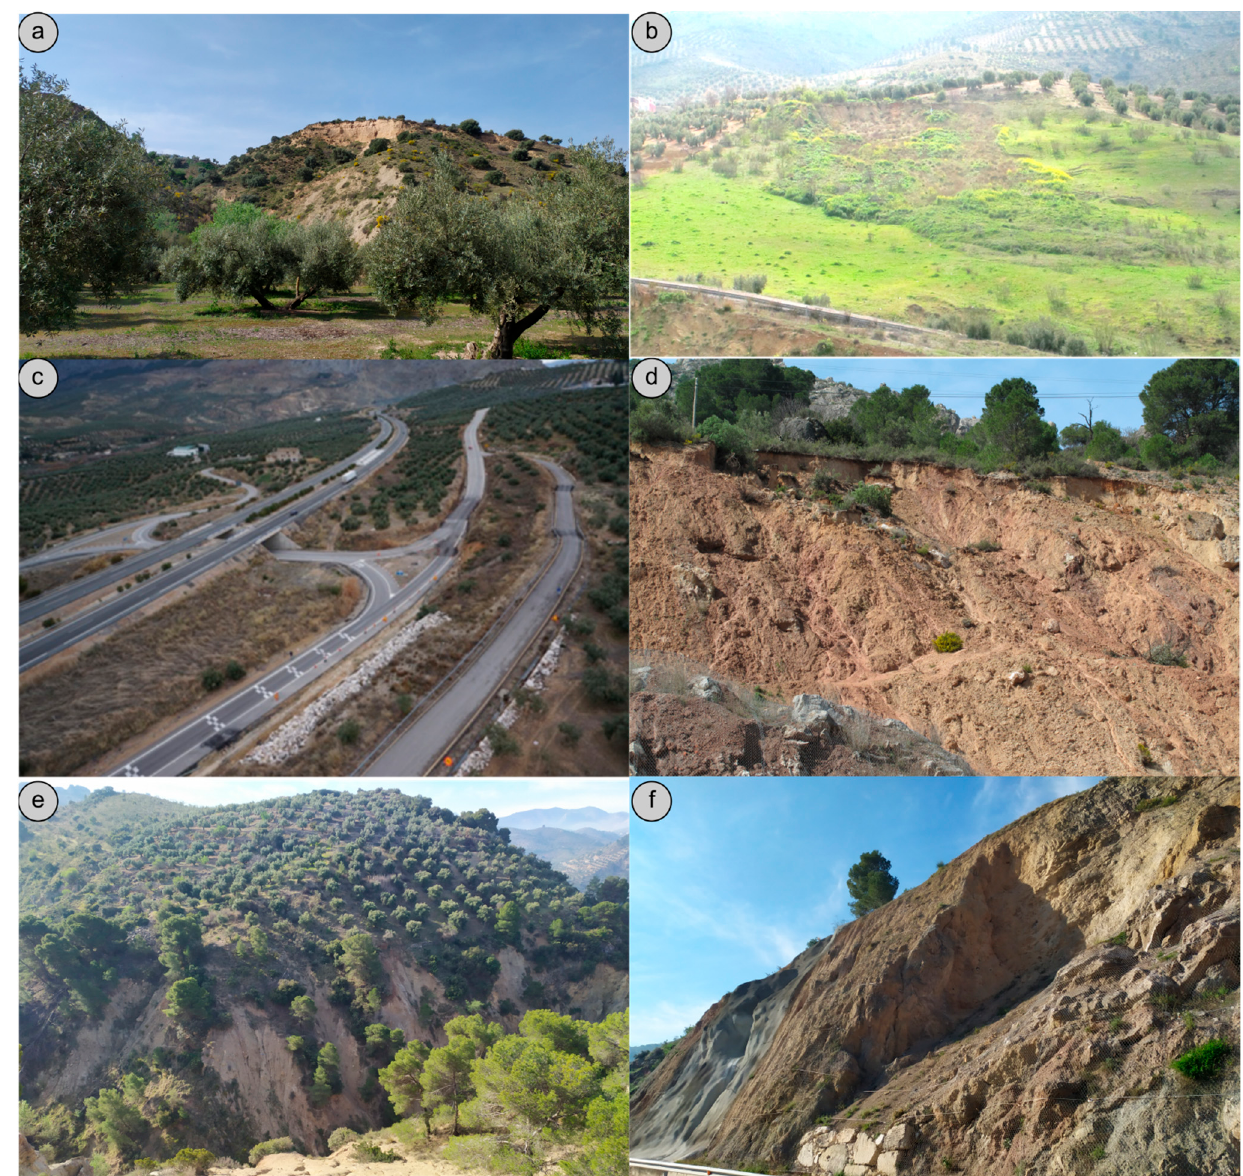
Figure 2. Examples of landslides in the study area: ( a ) collapses and slides in the area 1; ( b ) flow in the area 3; ( c ) foot of a flow in area 4 affecting roads; ( d ) slide in area 9; ( e ) natural collapses in area 9; ( f ) collapses in engineering slopes in area 10.